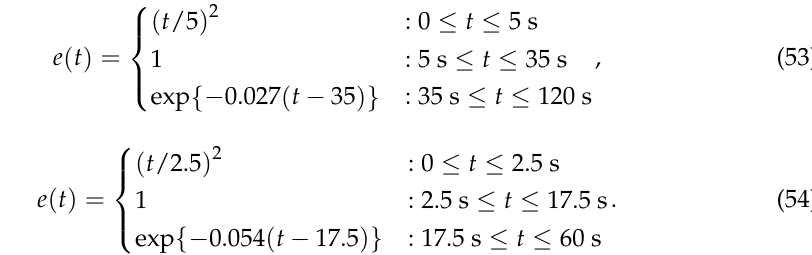
Figure 4. Time-histories of the artificial ground accelerations: ( a ) Art-L-00; ( b ) Art-S-00. Eleven artificial ground motions are generated from Art-L-00 and Art-S-00 by shifting the phase angle. The generated artificial ground motion a g ( t , ∆ φ 0 ) is expressed as